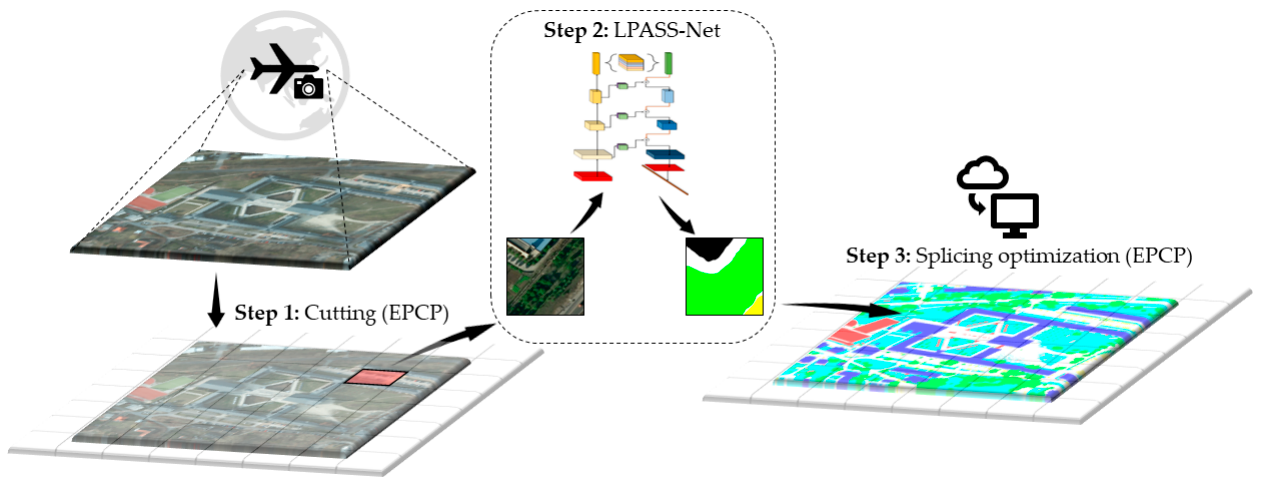
Figure 1. Flowchart of the proposed large-size and high-resolution remote sensing image semantic segmentation system.